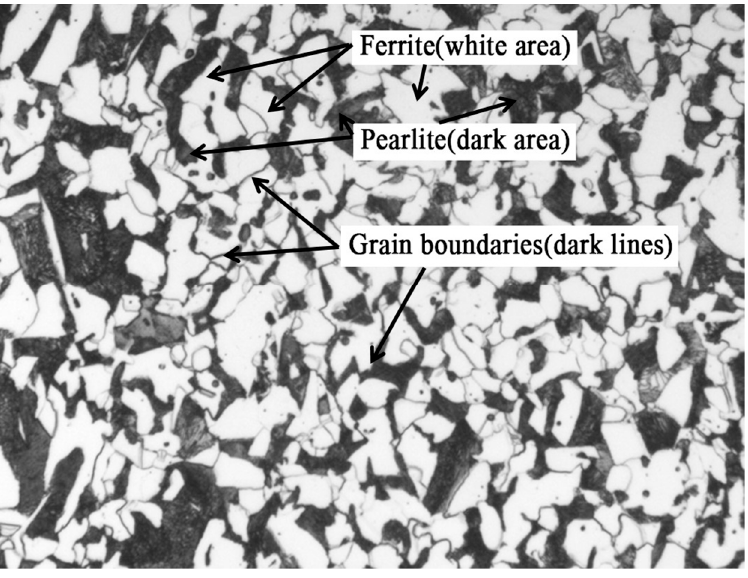
Figure 1. Typical ferrite–pearlite two-phase microstructure.